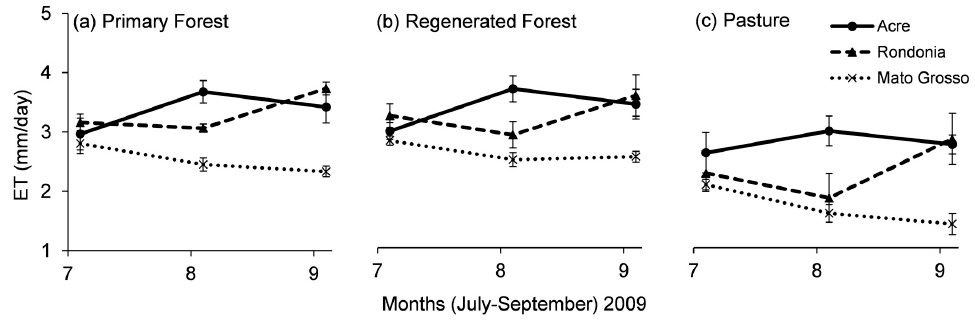
Figure 8. ET rates of ( a ) primary forest; ( b ) regenerated forest; and ( c ) pasture from three sites during the dry season (July–September) of 2009 at each study site.